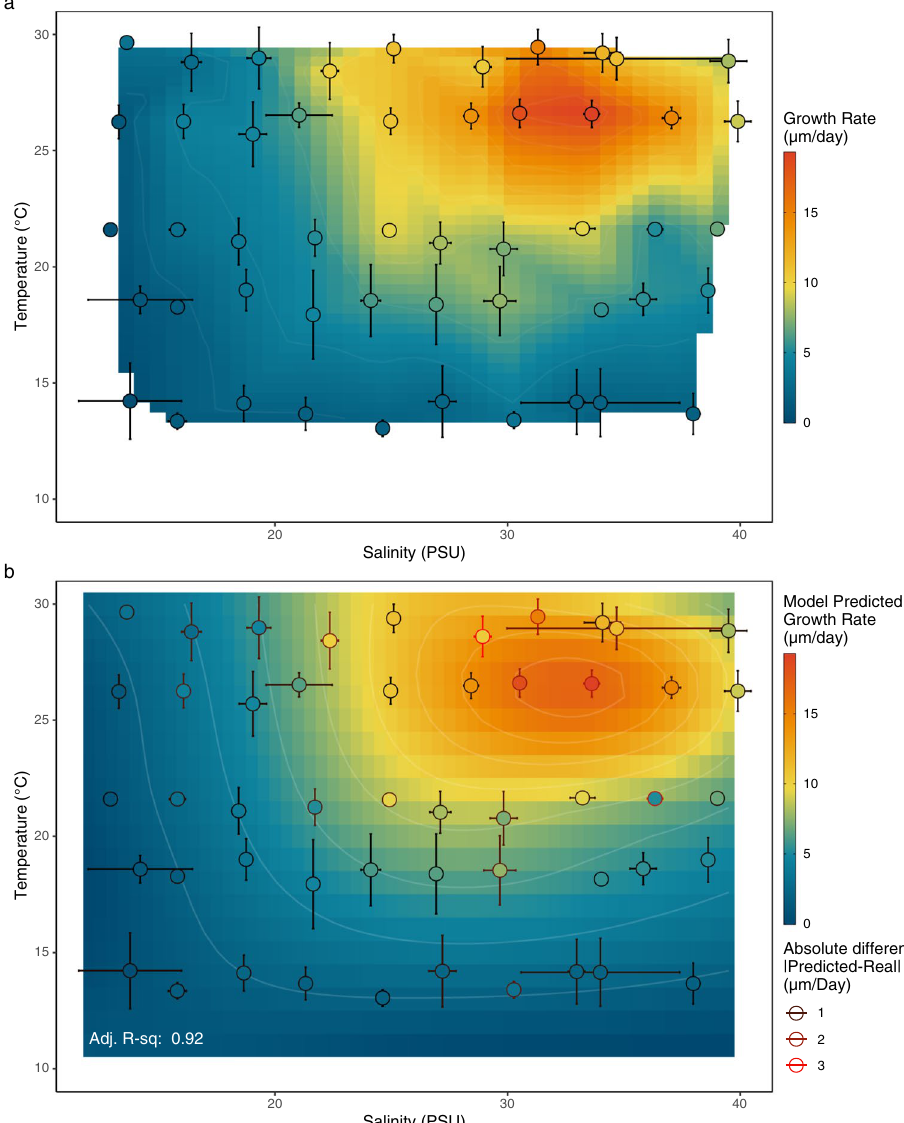
Figure 5. Real and predicted growth rates across environmental conditions. ( a ) Gridded Bivariate Interpolation of growth rate between experimental temperature and salinity coordinates, overlaid with real values of growth rate in experimental treatment points. ( b ) Predicted growth rate using Generalized Additive Model function at every salinity (9–39PSU) and temperature (11–30 °C) combination with experimental treatments overlaid. Color inside points represents the observed growth rate in that experimental treatment, while color of the panel represents modeled growth rate. Outline colors of points and error bars represent the absolute difference between real and predicted growth, where red outlined points are more poorly predicted by the